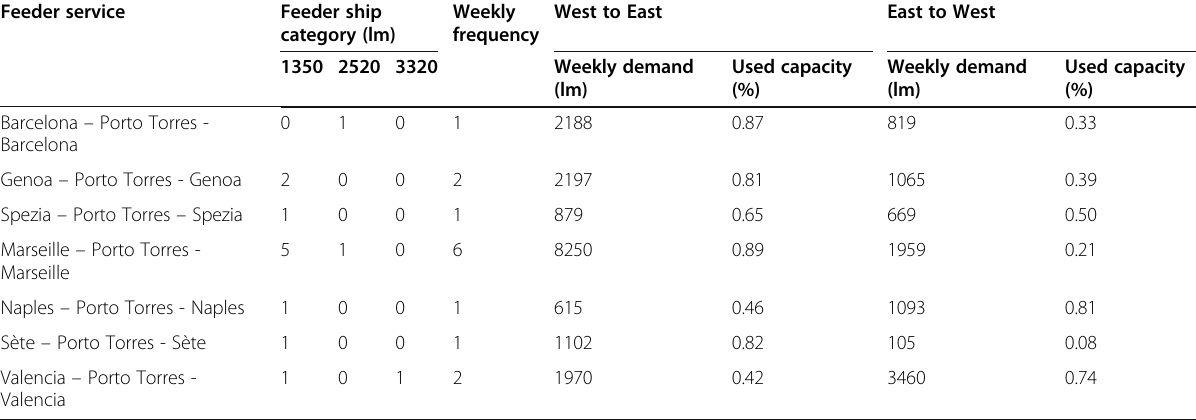
Table 20 Leg 1 - Western feeder services: frequencies and capacities Feeder service